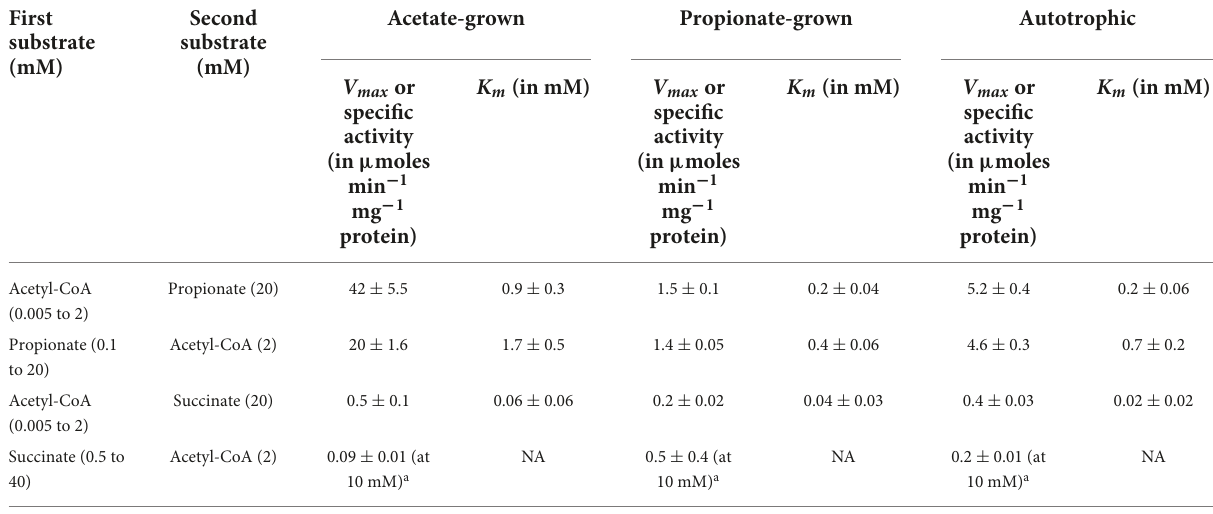
TABLE 3 Kinetics of CoA-transferase reaction in extracts of Desulfurella acetivorans cells grown under different conditions. First